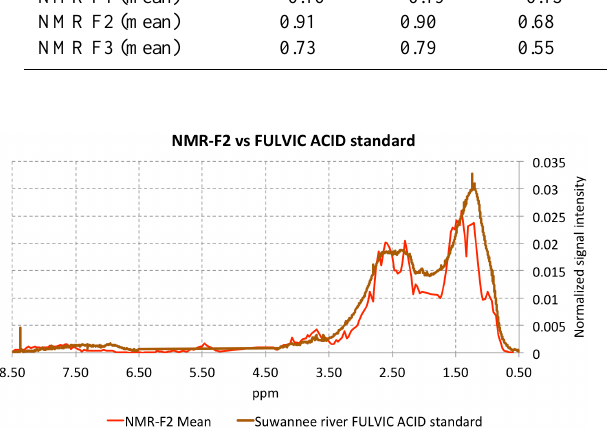
Fig. 4b. Spectral profile of NMR factor 2 (average profile) com- pared with the spectrum of the Suwannee River fulvic acid